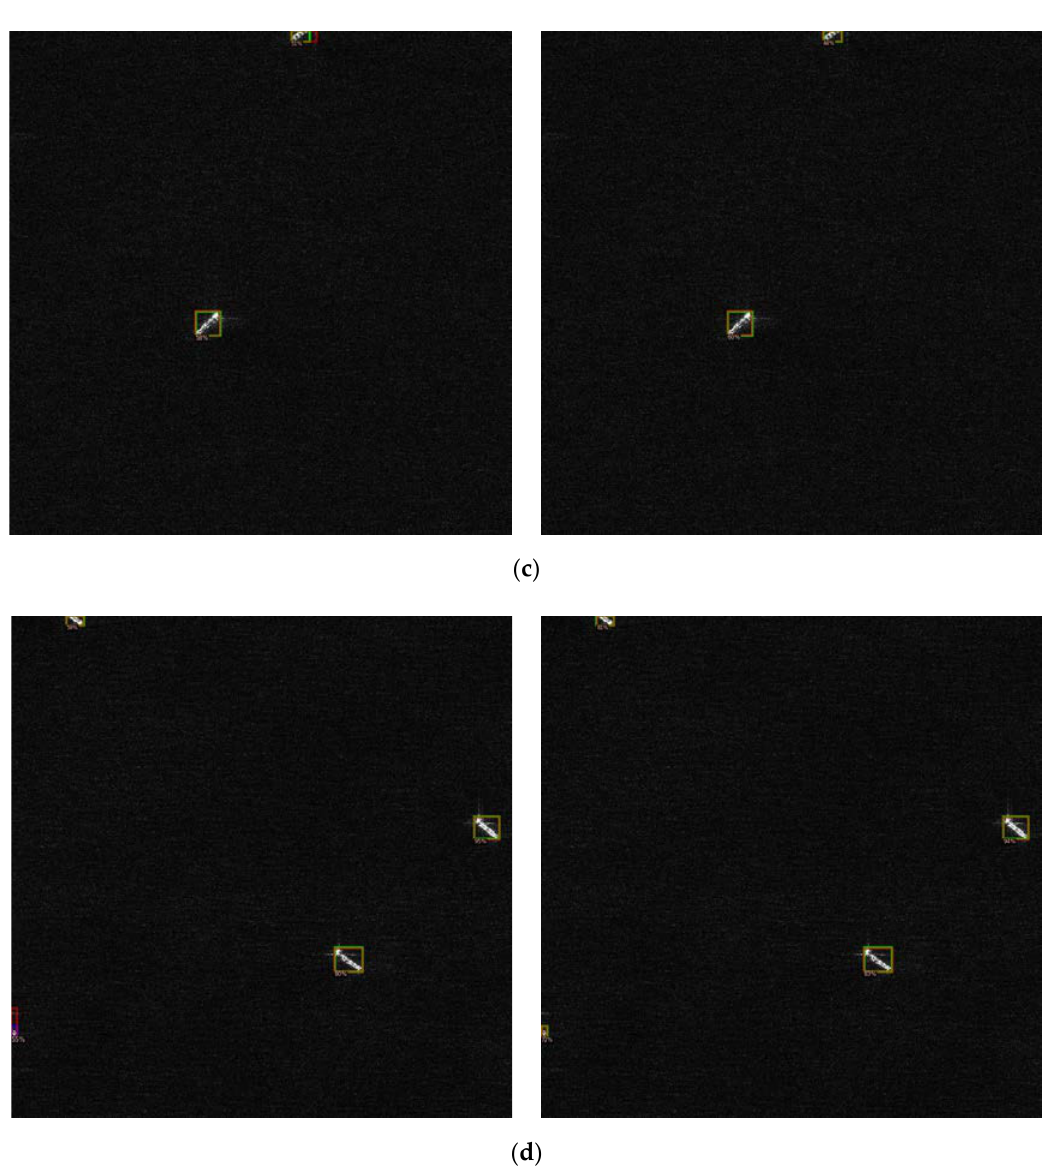
Figure 16. Comparison of detection results between traditional random cropping algorithm (left column in each panel) and the proposed method (right column in each panel) on small targets. The green boxes represent the true bounding boxes of the targets that were successfully detected. The blue boxes indicate the true bounding boxes of the targets that were not successfully detected. The red boxes represent the model prediction results, and the number on the red box represents the model’s confidence in this prediction result. ( a ) Example 1; ( b ) Example 2; ( c ) Example 3; ( d ) Example 4.